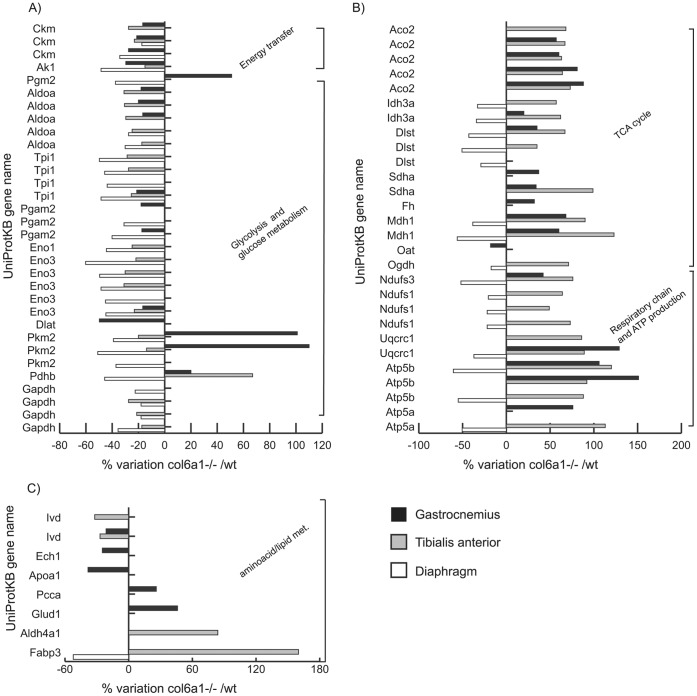
Histograms of differentially expressed metabolic proteins in muscles of Col6a1
−/−
versus wild-type controls.Histograms of differentially expressed proteins in gastrocnemius (black bars), tibialis anterior (grey bars) and diaphragm (white bars) muscles. Isoforms of proteins significantly altered (Student's T-test, p<0.01) are expressed as % of spot areas variation in Col6a1
−/−
versus wild-type controls. Panel A: energy transfer and glycolysis and glucose metabolism; panel B: TCA cycle, respiratory chain and ATP production; panel C: aminoacid and lipid metabolism. (Ckm: muscle creatine kinase; Ak1: adenylate kinase isoenzyme 1; Pgm2: phosphoglucomutase 2; Aldoa: fructose-bisphosphate aldolase A; Tpi1: triosephosphate isomerase 1; Pgam2: phosphoglycerate mutase 2; Eno1: enolase 1 (alpha); Eno3: enolase 3 (beta muscle); Dlat: dihydrolipoyllysine-residue acetyltransferase; Pkm2: pyruvate kinase isozymes M1/M2; Pdhb: pyruvate dehydrogenase (lipoamide) beta; Gapdh: glyceraldehyde-3-phosphate dehydrogenase; Aco2: aconitase 2; Idh3a: isocitrate dehydrogenase [NAD] subunit alpha; Dlst: dihydrolipoamide S-succinyltransferase; Sdha: succinate dehydrogenase complex, subunit A; Fh: fumarate hydratase 1; Mdh1: cytosolic malate dehydrogenase; Oat: ornithine aminotransferase; Ogdh: 2-oxoglutarate (α-ketoglutarate) dehydrogenase; Ndufs3: NADH dehydrogenase (ubiquinone) iron-sulfur protein 3; Ndufs1: NADH dehydrogenase (ubiquinone) Fe-S protein 1; Uqcrc1: ubiquinol-cytochrome-c reductase complex core protein I; Atp5b: ATP synthase, H+ transporting mitochondrial F1 complex, beta subunit; Atp5a: ATP synthase subunit alpha; Ivd: isovaleryl-CoA dehydrogenase; Ech1: delta (3,5)-delta(2,4)-dienoyl-CoA isomerase; Apoa1: Apolipoprotein A-I; Pcca: propionyl-CoA carboxylase alpha chain; Glud1: glutamate dehydrogenase 1; Aldh4a1: delta-1-pyrroline-5-carboxylate dehydrogenase; Fabp3: fatty acid-binding protein).